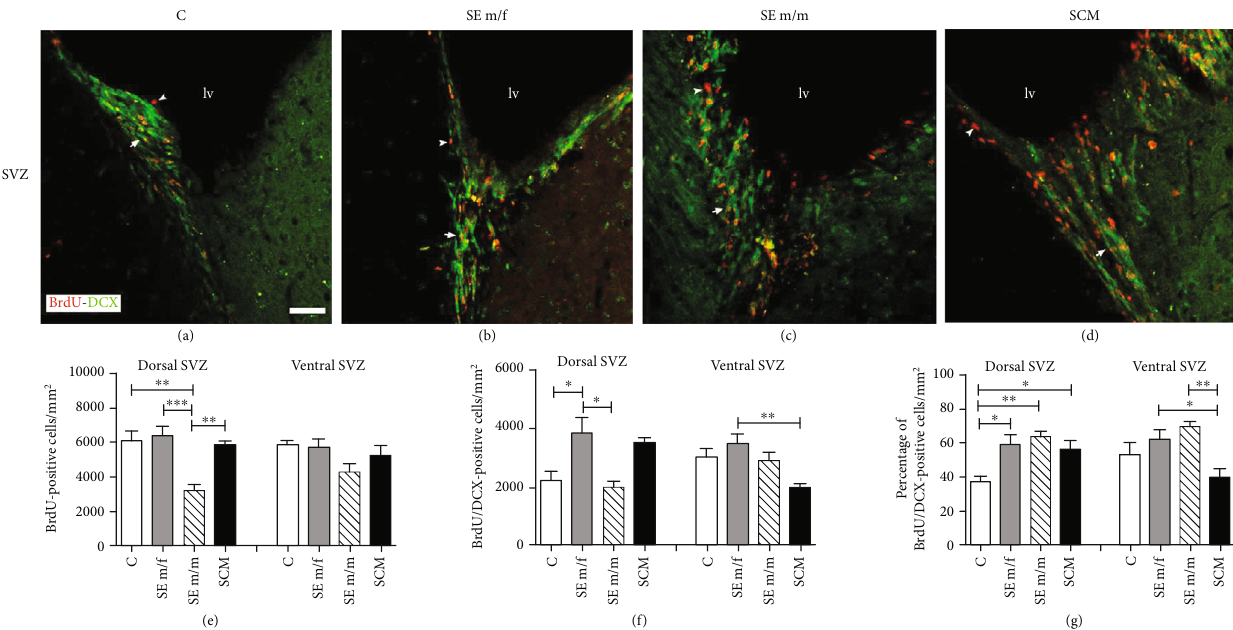
Figure 3: Representative photomicrographs of double immunolabeling for BrdU (red) and DCX (green) in the dorsal SVZ in the control (C; (a)), social exposure to a female (SE m/f; (b)), social exposure to a male (SE m/m; (c)), and social cohabitation with mating (SCM; (d)). White arrows indicate BrdU-positive/DCX-positive cells (organized in chain arrangements), and white arrowheads indicate BrdU-positive/DCX- negative cells. Photomicrographs were taken at 20x. Scale bar: 100 μ m. Data analysis of cell proliferation, total BrdU/DCX-positive cells, and percentage of BrdU/DCX-positive cells in the C, SE m/f, SE m/m, and SCM animals are shown in (e – g). lv: lateral ventricle. Data were analyzed by one-way ANOVA followed by Bonferroni ’ s post hoc tests. ∗ p < 0 : 05 and ∗∗ p < 0 : 01 . Results of ANOVA analyses are provided in the text. Dorsal SVZ: C ( n = 7 ), SE m/f ( n = 7 ), SE m/m ( n = 6 ), and SCM ( n = 6 ); ventral SVZ: C ( n = 5 ), SE m/f ( n = 7 ), SE m/m ( n = 6 ), and SCM ( n = 6 were no signi fi cant di ff erences in the percentage of BrdU/DCX-positive cells between groups ( F ð = 2 : 4 , p = 3 , 21 Þ 0 : 1 , η 2 = 0 : 3 ; Figure 5(c)).